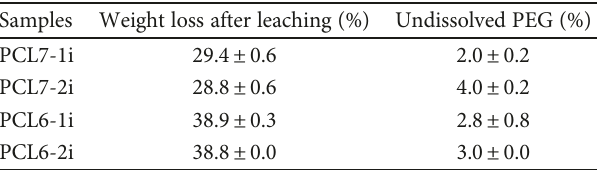
Table 2: Percentage of weight loss in blends due to PEG dissolution and percentage of undissolved PEG with respect to the initial PEG